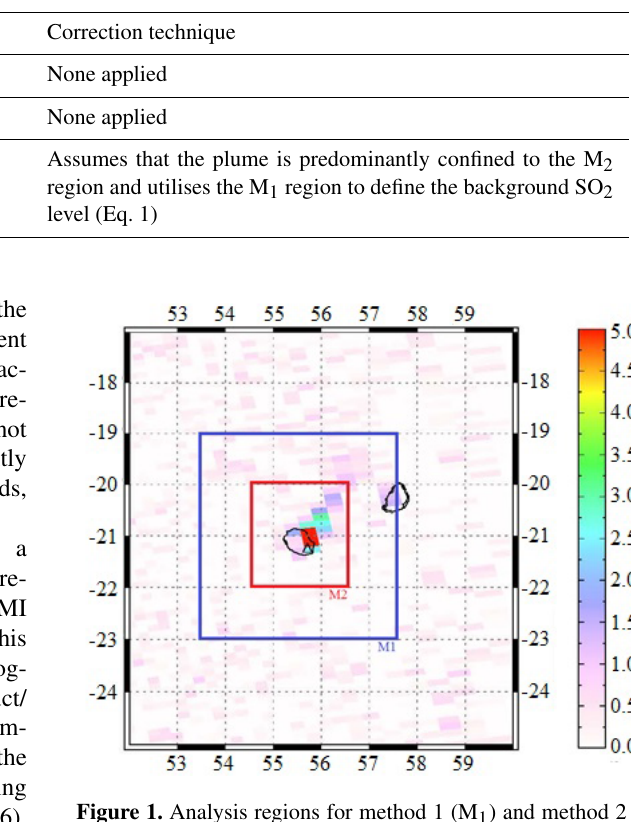
Figure 1. Analysis regions for method 1 (M 1 ) and method 2 (M 2 ) for an SO 2 plume detected by OMI at Piton de la Fournaise, Réu- nion, on 24 February